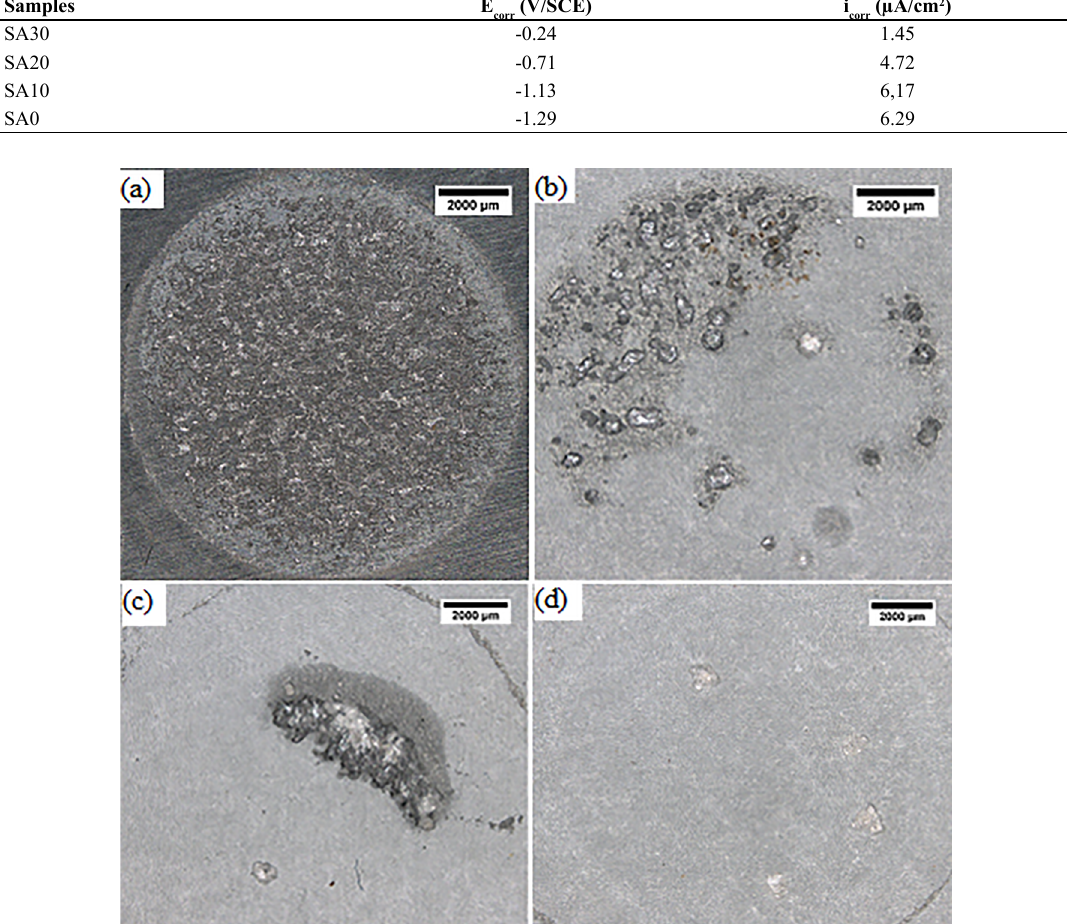
) and corrosion current density (i corr